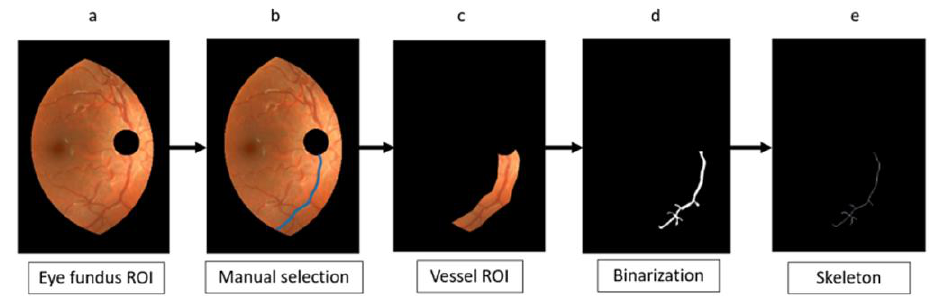
Figure 4. Flow chart for vessel-ROI segmentation, binarization, and skeletonization: from the eye fundus ROI ( a ), a vessel is manually selected ( b ). The vessel ROI is segmented ( c ), binarized ( d ), and skeletonized ( e ).